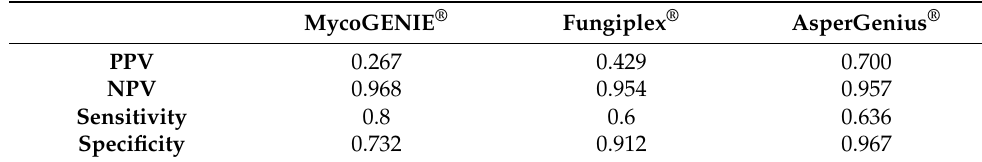
Table 4. Statistical analysis of samples categorised as probable IPA vs. possible/not categorisable IPA